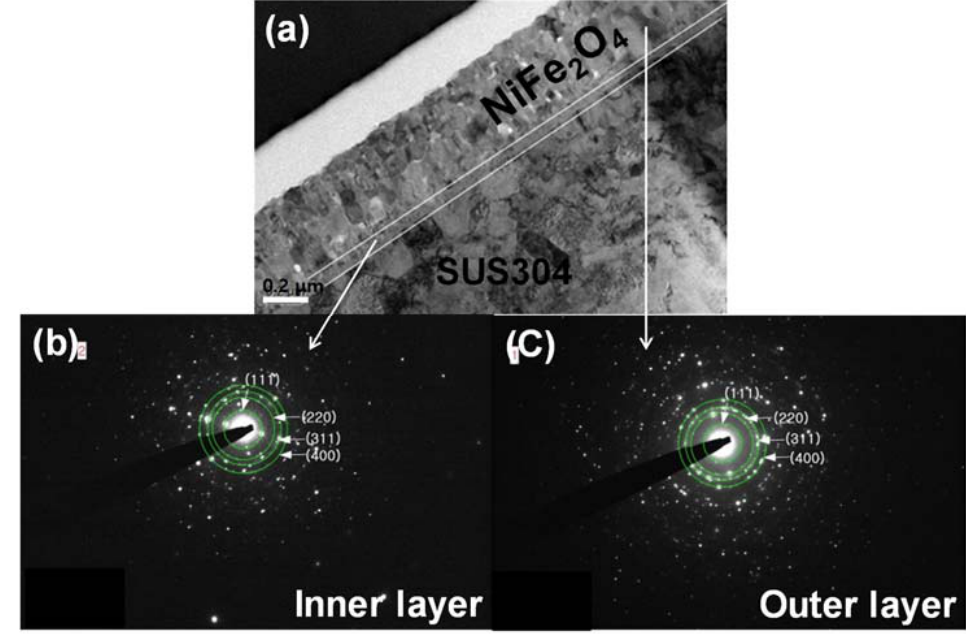
Figure 4. SAED pattern for the NFO-800 electrode. ( a ): cross-section; ( b ): Inner layer; ( c ): Outer layer.